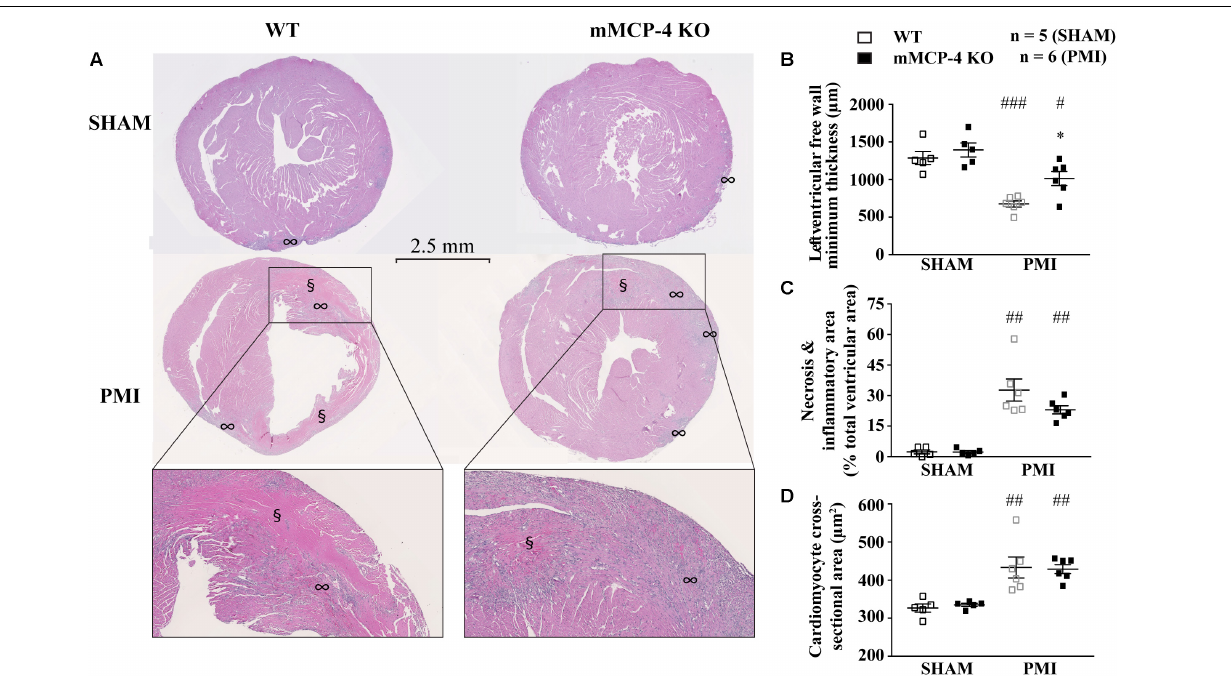
59.6 ± 11.0 pg/ml, n = 6; WT PMI: 58.7 ± 7.0 pg/ml; and mMCP- 4 KO PMI: 65.3 ± 8.2 pg/ml, n = 6). Plasma BNP levels